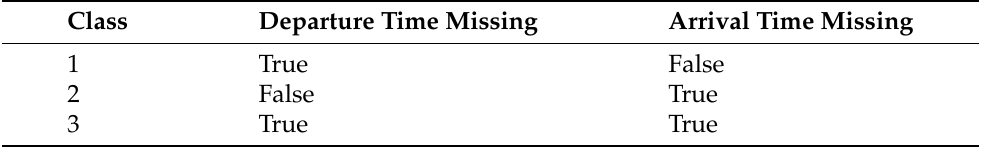
Table 3. Classes of missing